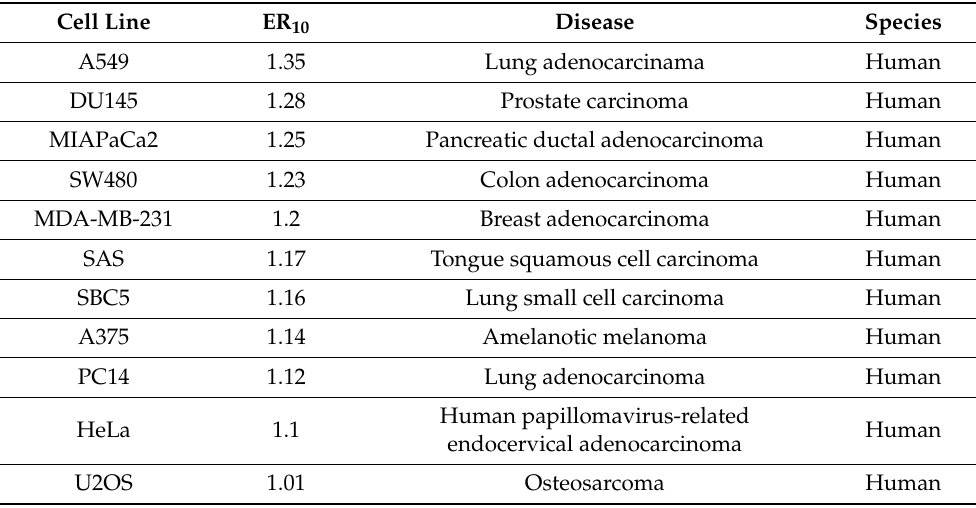
Table 1. The enhancement ratios at 10% survival (ER 10 ) to cell